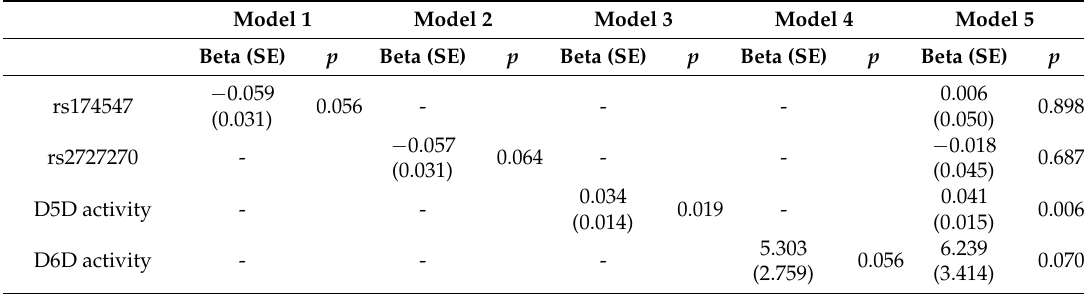
Table 5. Associations among FADS1 rs174547, FADS2 rs2727270, desaturases activities and HDL-C levels type 2 diabetes using multiple linear regression analysis ( n = 176).